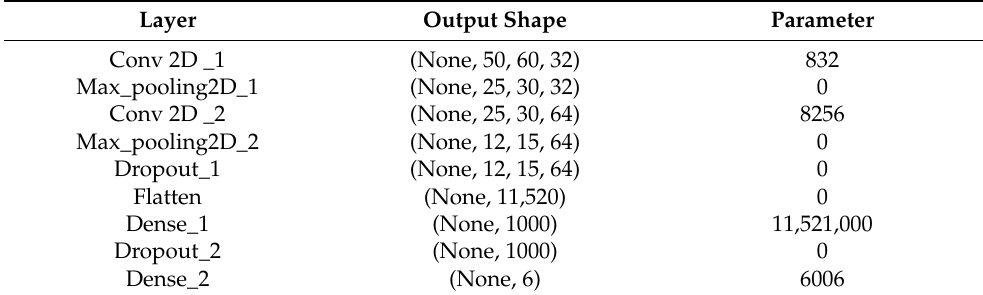
Table 7. Layers and number of parameters in the joint position input model.